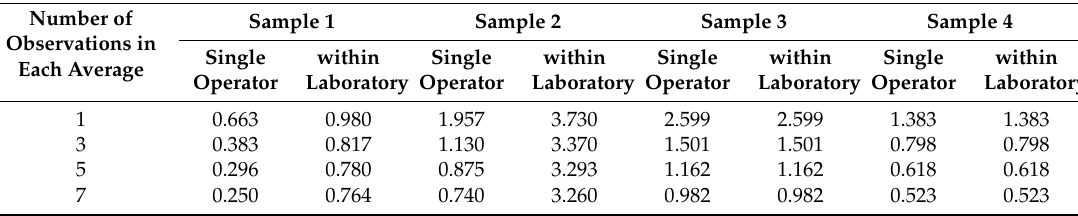
Table 8. Critical differences of maximum bending force for bending properties.